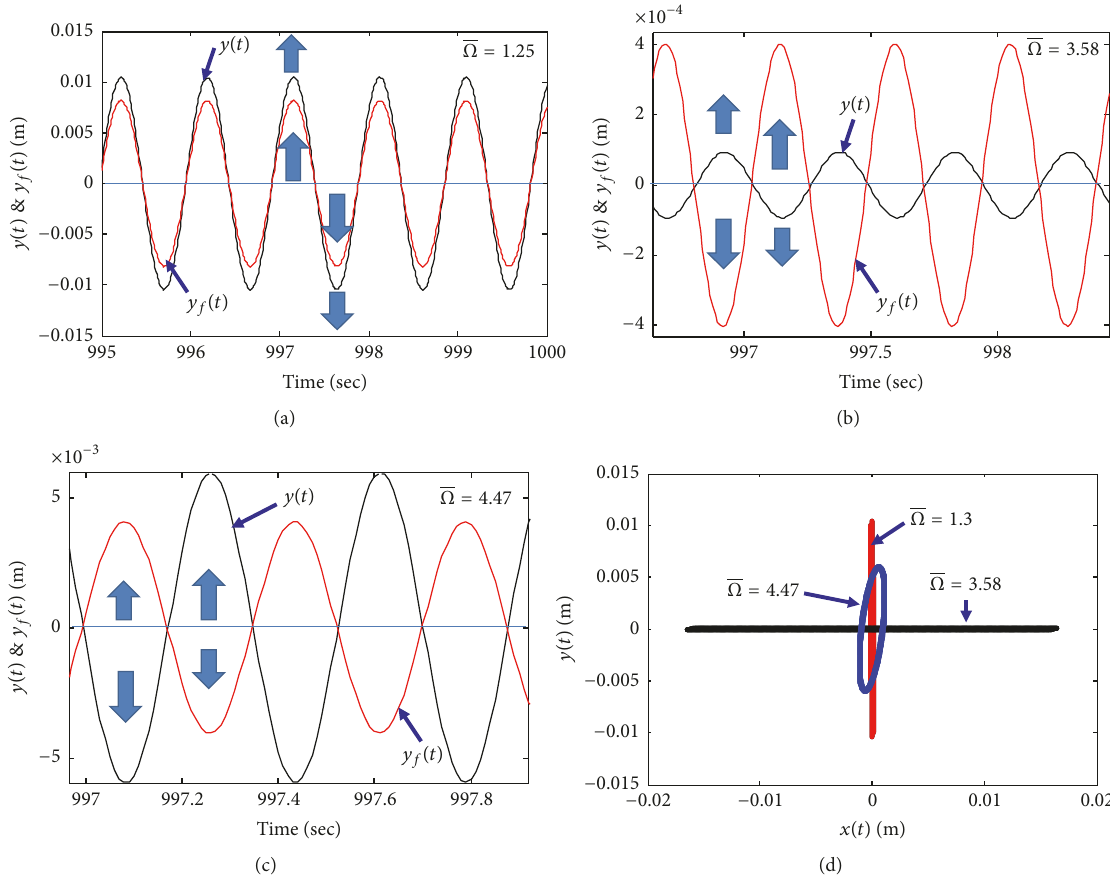
Figure 5: Coupled oscillating behavior of rotor and foundation and rotor whirl orbits under limit cycle condition ((a) at Ω = 1.27 , (b) at Ω = 2.93 , and (c) at Ω = 3.79 ).